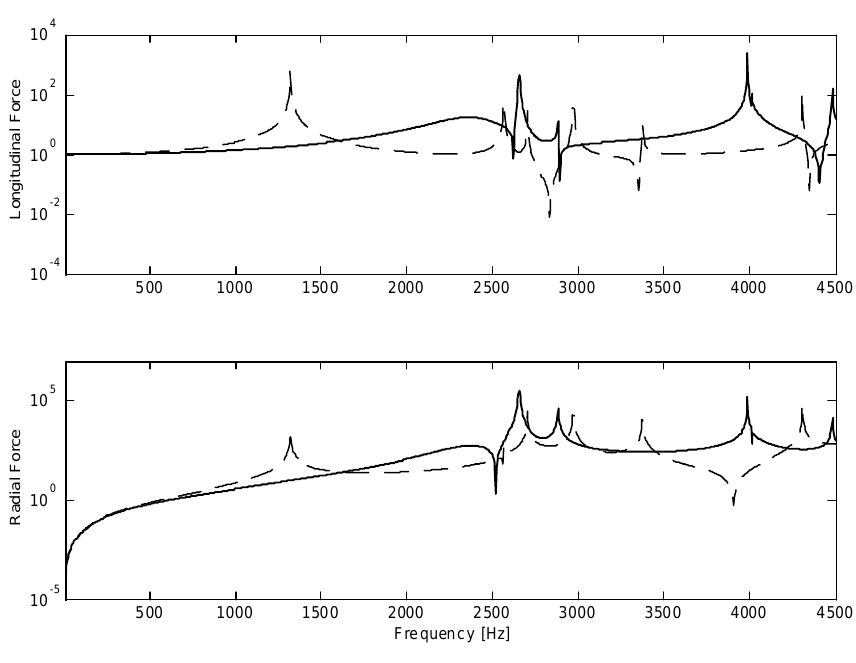
Fig. 13. Transmitted force: type (A) tapered shell (solid), uniform shell (dashed).